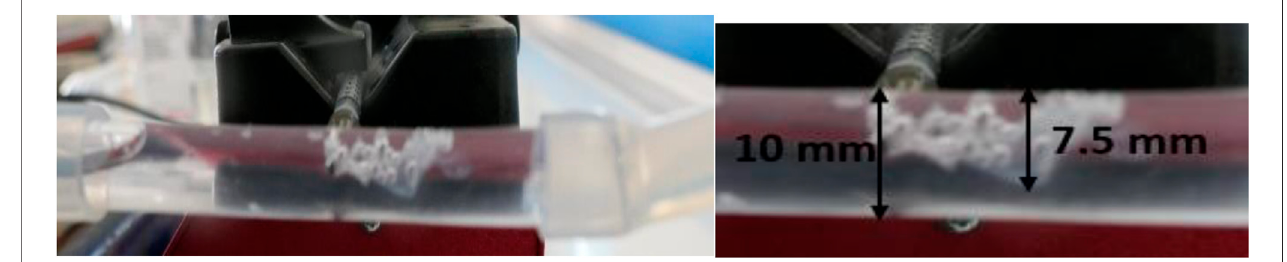
FIGURE 9 | Clot formed in experimental study after 30 s.